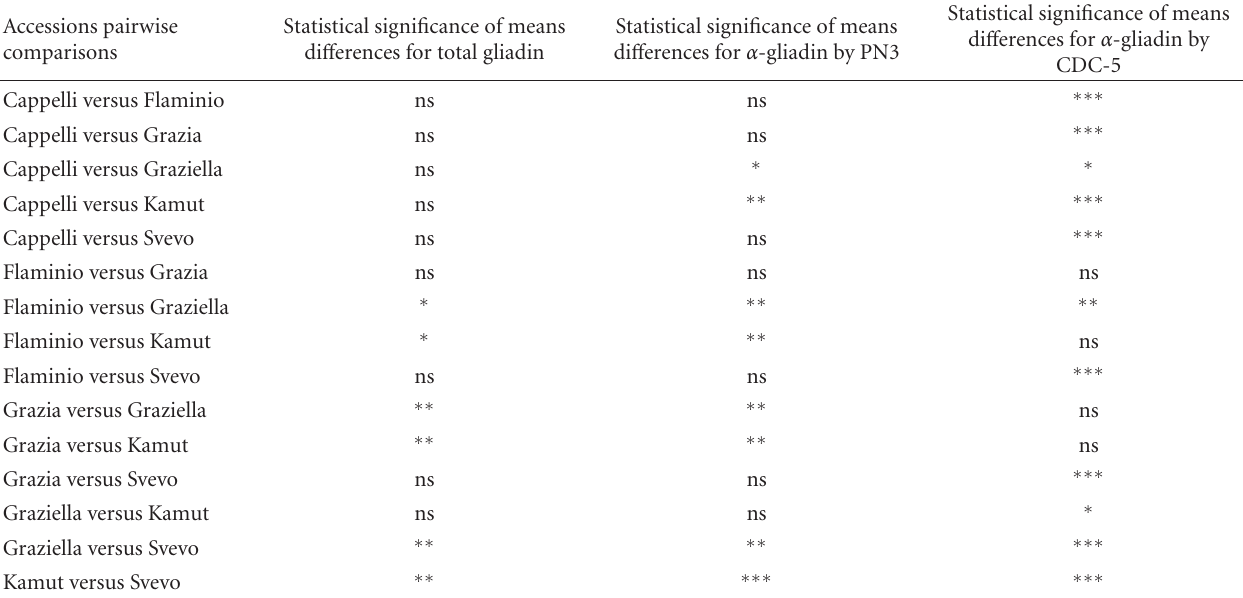
Table 1: Results of Bonferroni multiple comparison post hoc